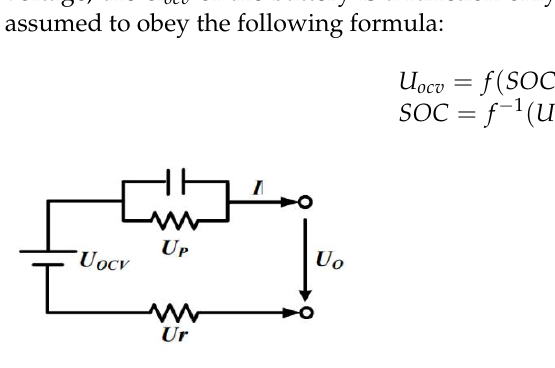
Figure 1. The model of circuit.